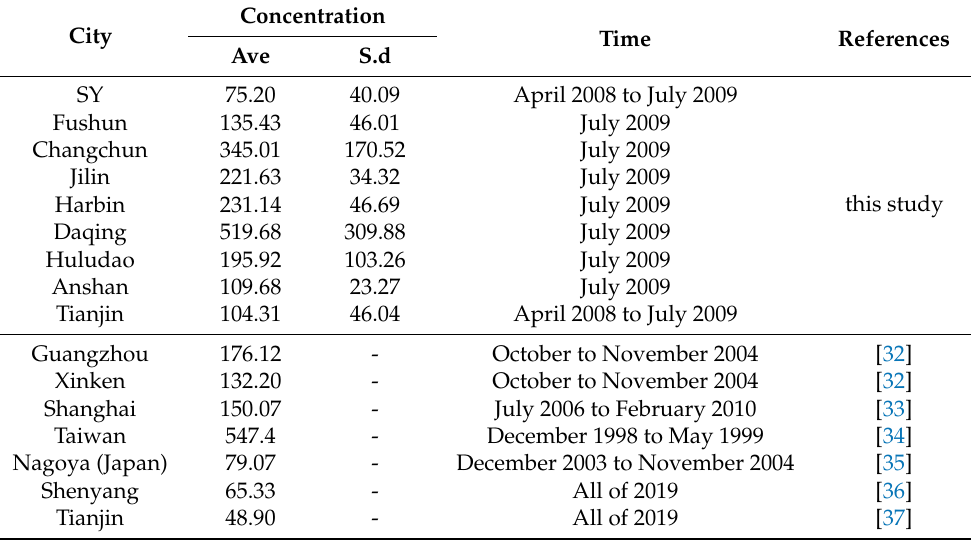
Time References